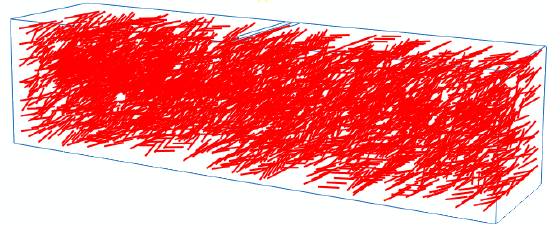
Figure 8. 3D random-distribution fiber model.